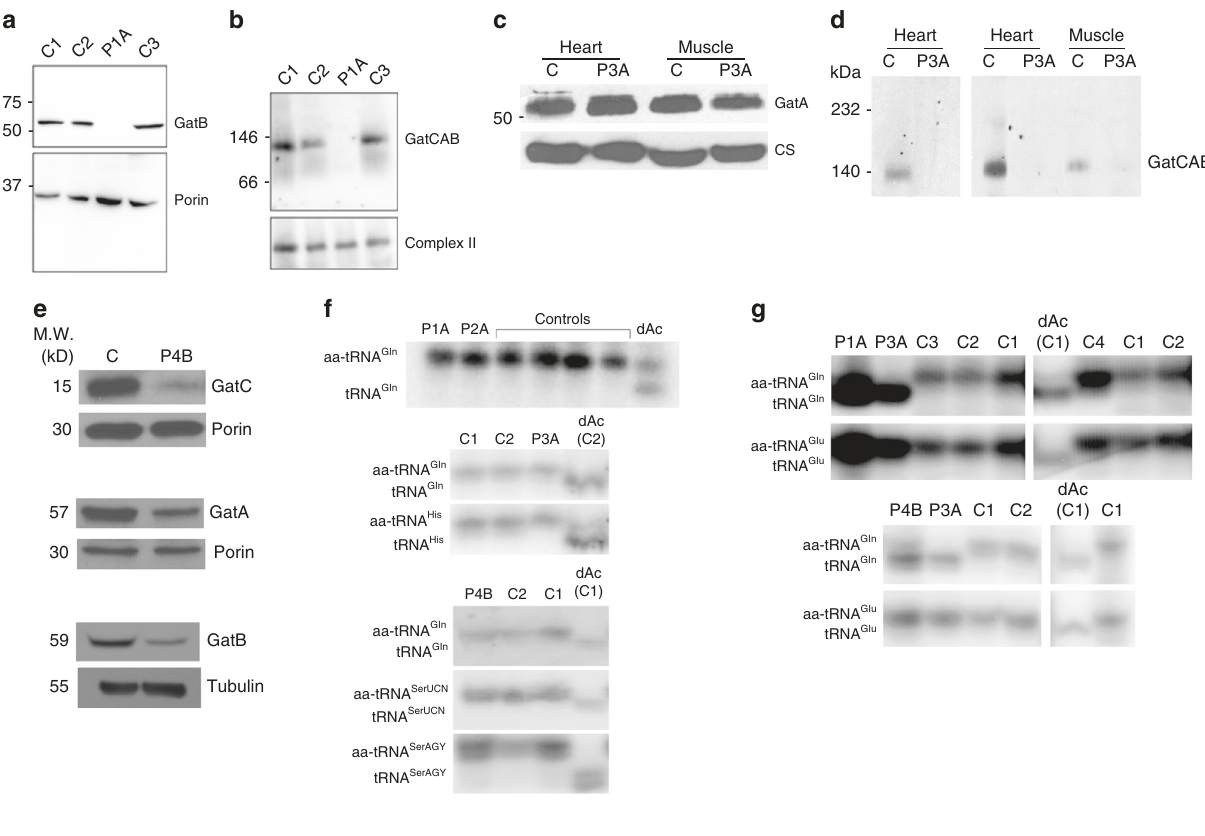
Fig. 3 GatCAB protein expression levels and mitochondrial tRNA aminoacylation analysis. a Western blot after SDS-PAGE shows a near absence of GatB protein in the fi broblasts of patient P1A in contrast to three controls (C#1 – 3), with porin and tubulin as loading controls; b Western blot after BN-PAGE show the GatCAB protein complex as an approximately 120 kDa complex in controls, but is not detectable in P1A fi broblasts, with complex II used as loading control. c Western blot from both control (C) and patient P3A skeletal and heart muscle shows normal amount and size of the GatA protein, with citrate synthase (CS) as loading control. d The assembly of the GatCAB complex on native polyacrylamide gradient gel and western blot probed with anti- GatB antibody in heart and muscle tissues of both control (C) and patient P3A shows absence of the holocomplex at approximately 120 kDa in patient samples. e Western blot analysis of control and patient P4B fi broblasts showed a strong reduction in GatC protein, and also reduced levels of GatA and GatB protein, with porin as loading control. f Northern blot analysis of mitochondrial tRNA aminoacylation in total RNA samples from patients P1A and P2A, and control human fi broblasts show similar glutamine charging of mt-tRNA Gln when cells were grown in standard glutamine-containing medium, with similar results for fi broblasts from P3A and P4B. g After 3 days in culture medium without glutamine, fi broblasts from P1A, P3A, and P4B show decreased glutamine charging of mt-tRNA Gln compared to control fi broblasts. “ dAc ” indicates deacylated control